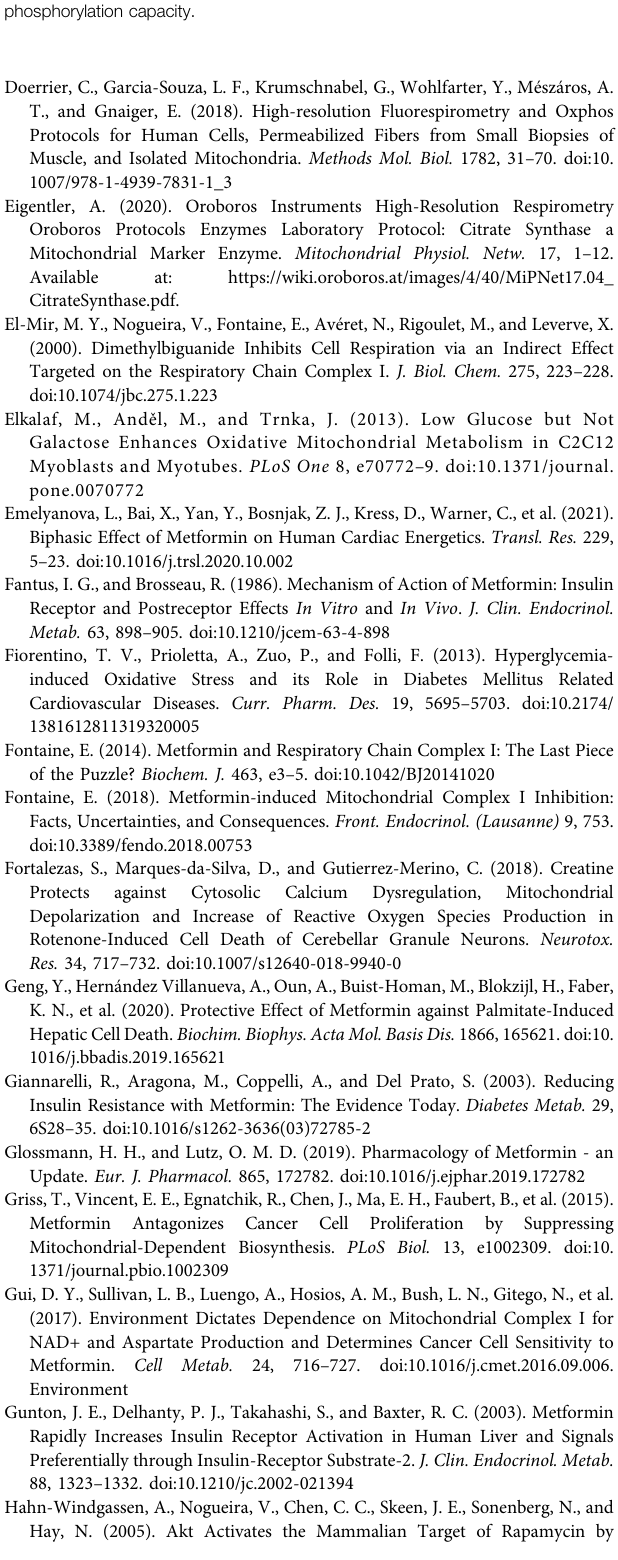
states, all corrected forROX, from 3to5independentexperiments arepresentedas scatter plots, with mean ± SD, * p < 0.05. OXPHOS-N — NADH-linked